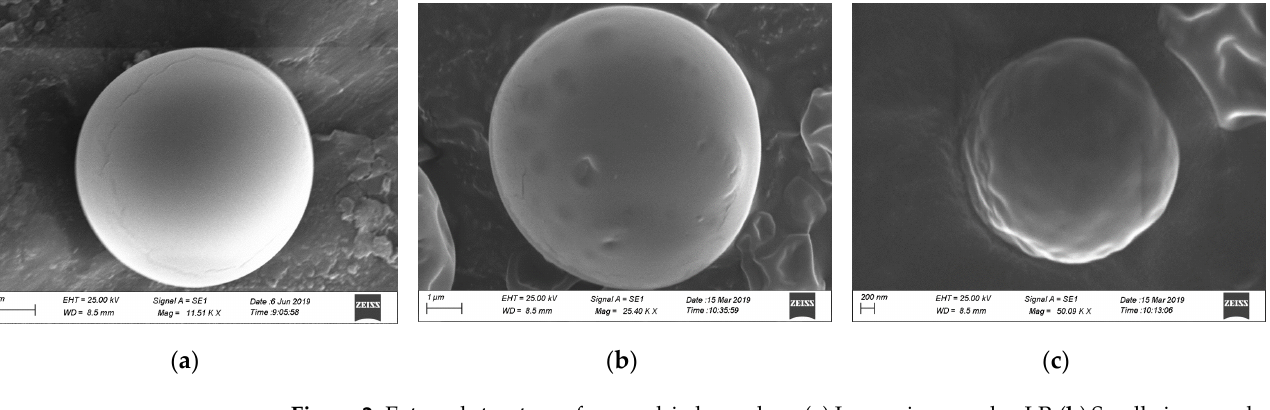
Figure 2. External structure of spray-dried powders: ( a ) Large-size powder, LP. ( b ) Small-size pow- der, SP. ( c ) Nano-size powder,